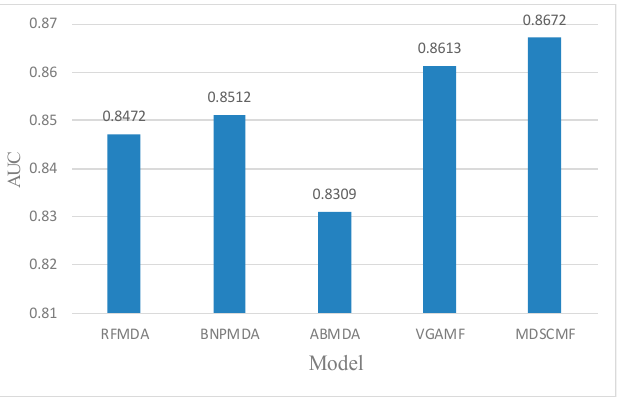
Figure 3. Comparisons between MDSCMF and other computational models by local LOOCV.